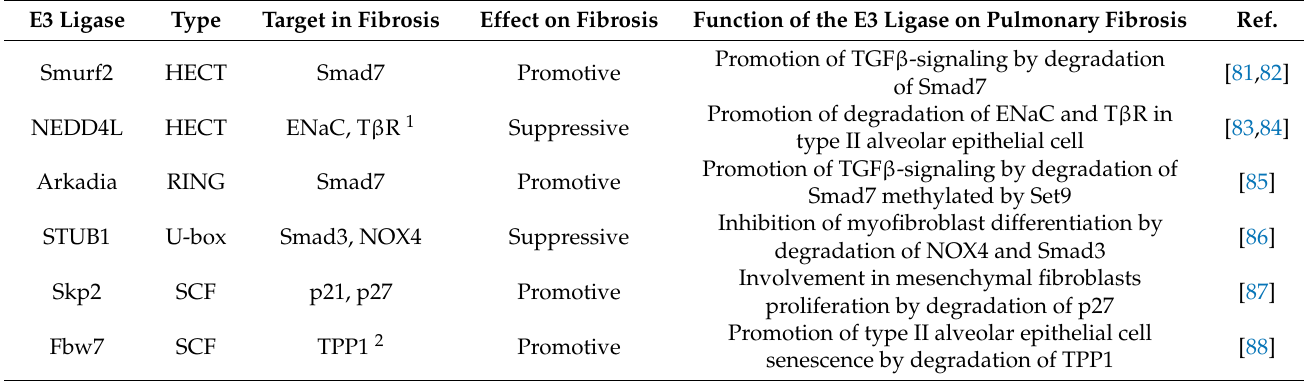
Table 1. E3 ligases involved in promotion and suppression of pulmonary